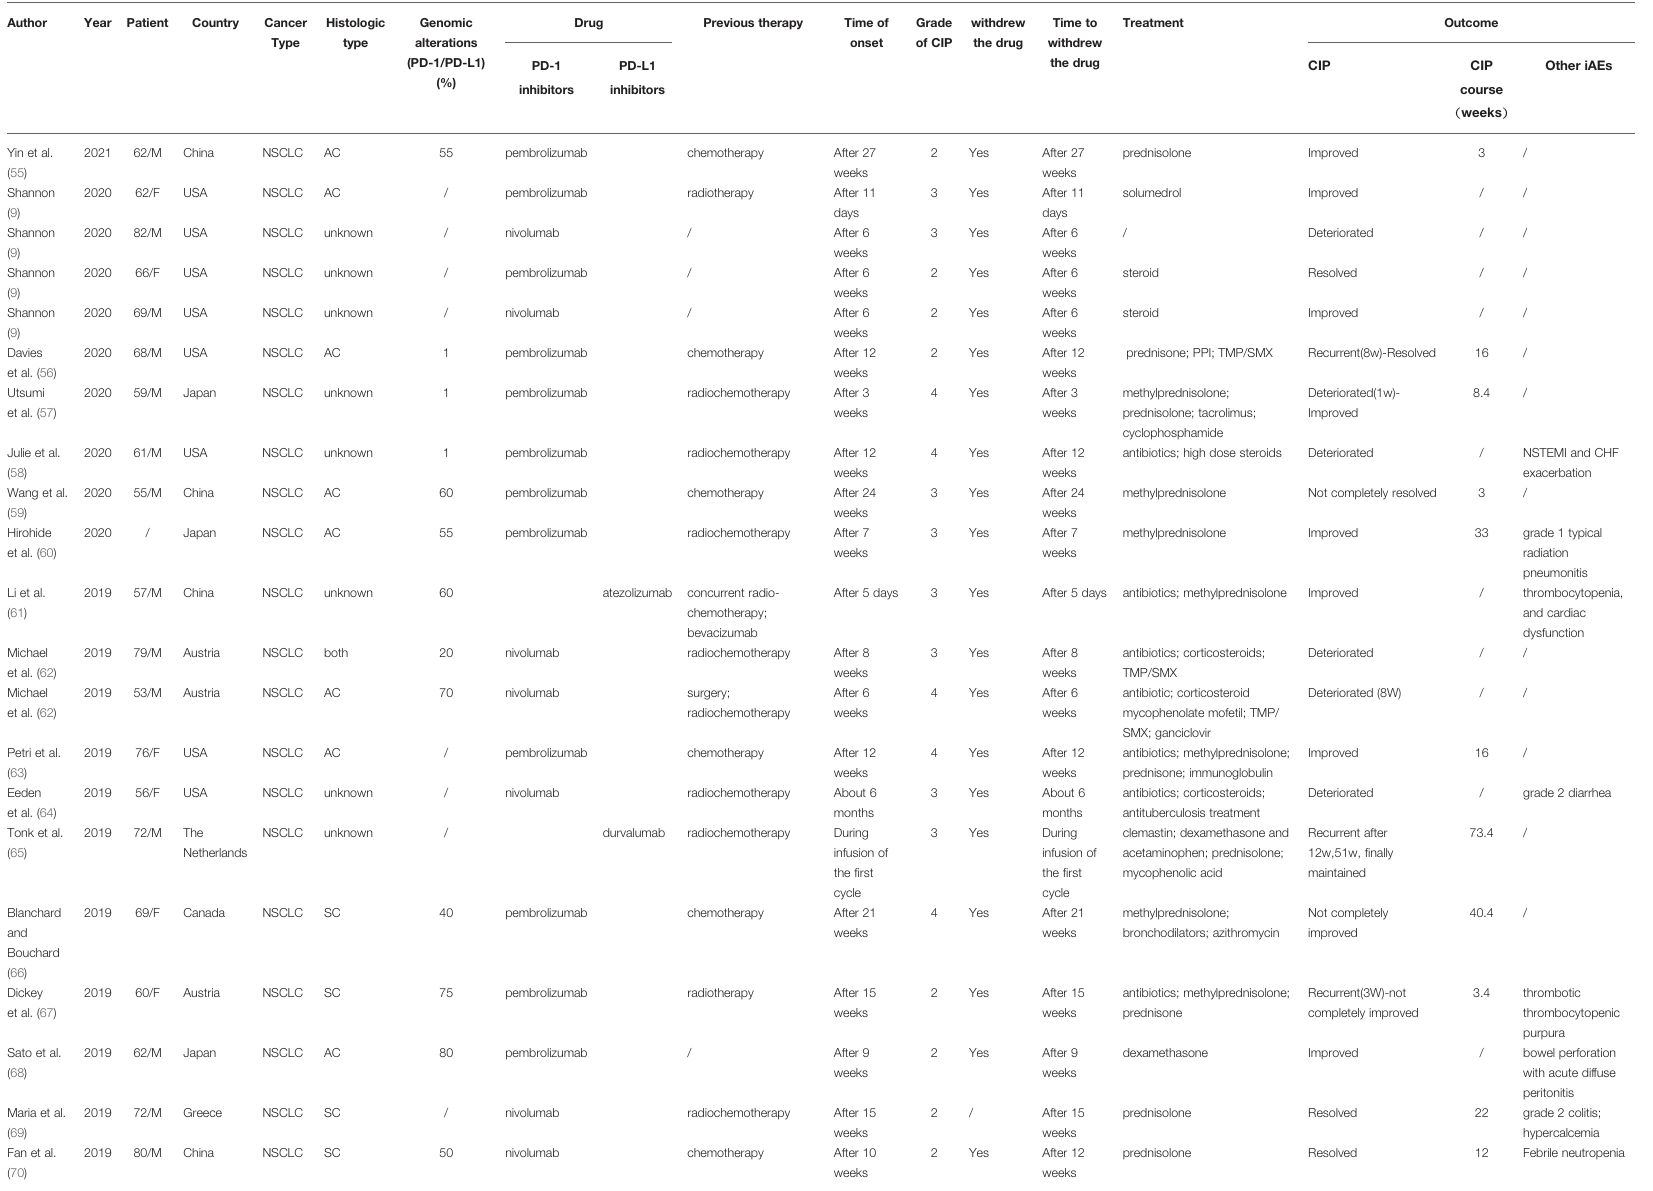
TABLE 1 | Published case reports and case series of immune checkpoint inhibitor-associated